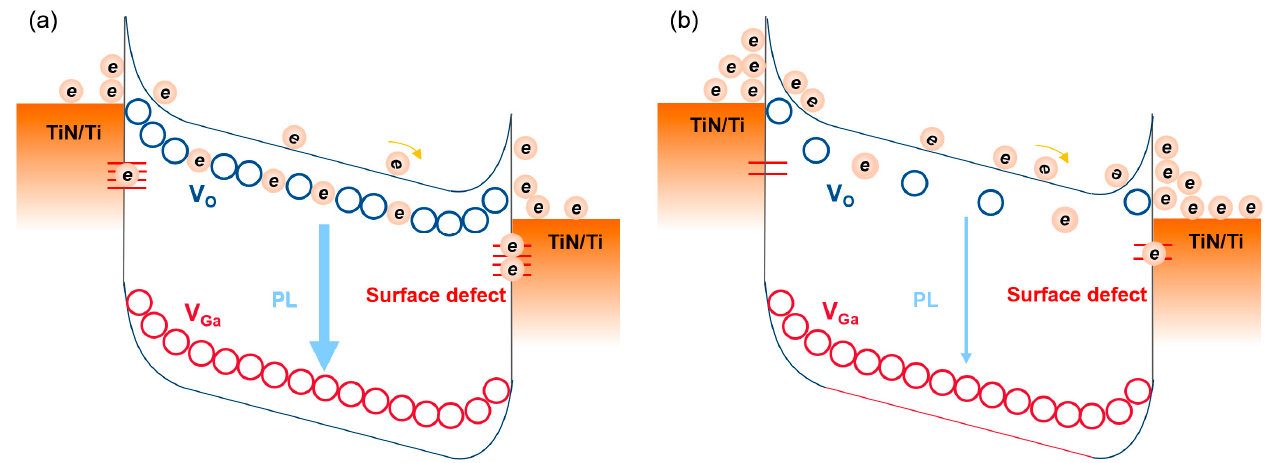
Figure 4. Schematic energy band structure of β -Ga 2 O 3 MSM PD with donor and acceptor levels ( a ) before and ( b ) after PN treatment. Electron trap sties in blue while hole trap sites in red.